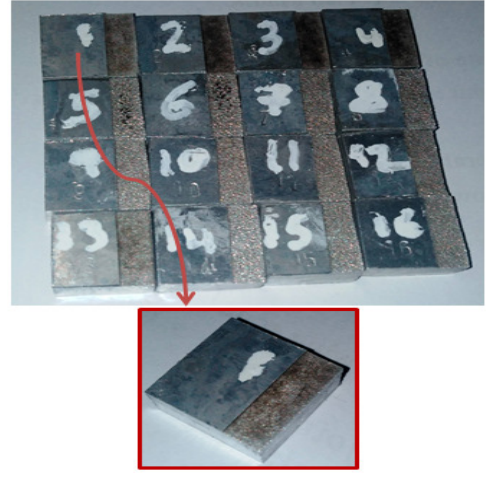
Fig. 2. Work piece Samples of Al-6061 Alloy